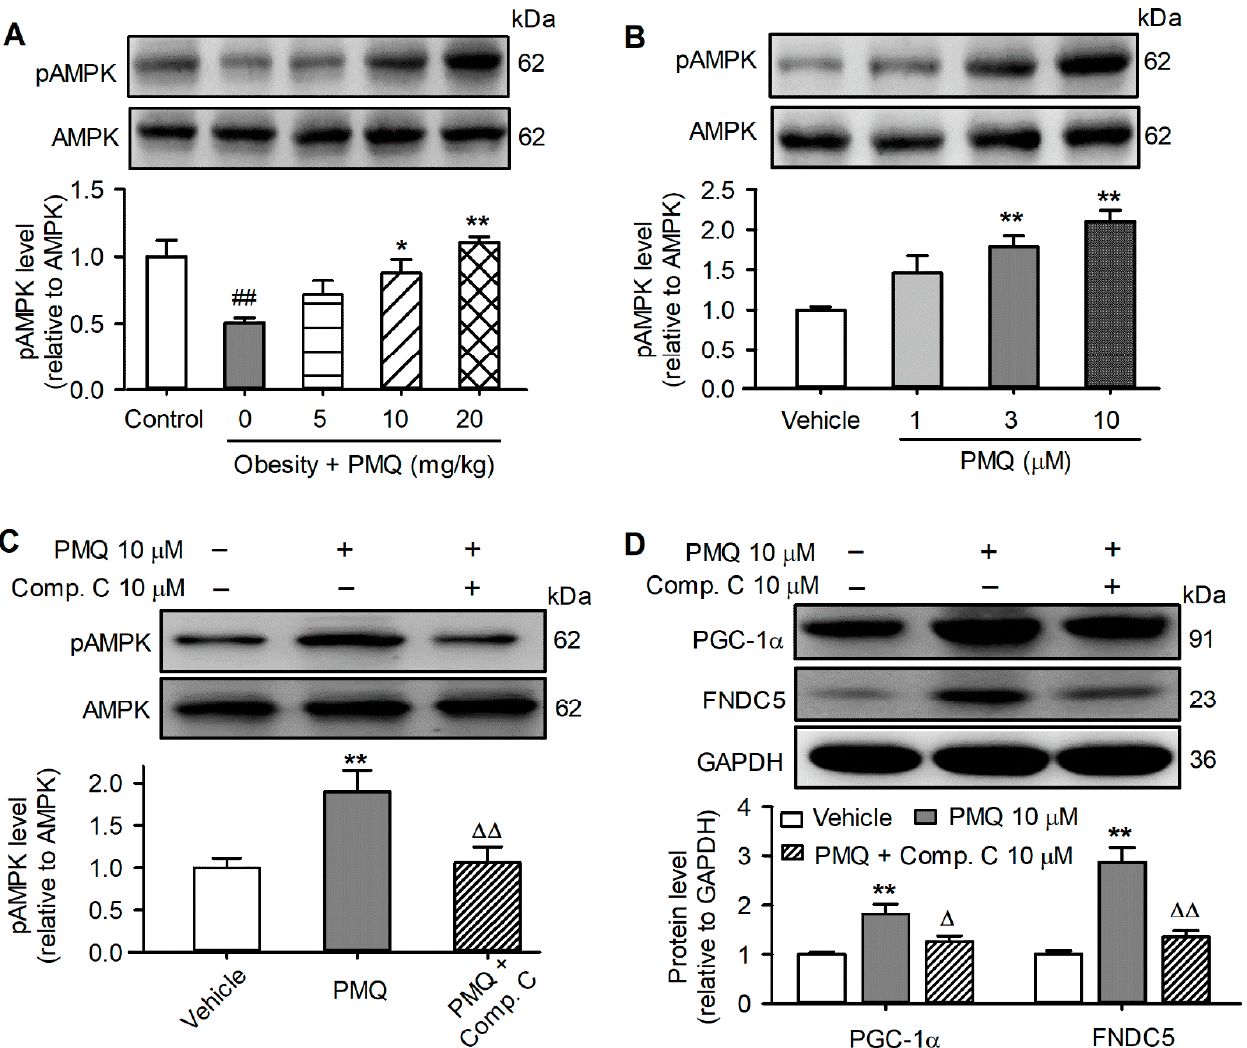
Figure 7. PMQ enhances PGC-1 α and FNDC5 protein expression by activating AMPK. ( A ) Protein levels of pAMPK and AMPK in gastrocnemius muscle of mice. ## p < 0.01 vs control group; * p < 0.05, ** p < 0.01 vs MSG group. ( B ) Protein levels of pAMPK and AMPK in C2C12 myotubes treated with various concentrations of PMQ (1, 3, 10 μ M) or vehicle for 16h. ** p < 0.01 vs vehicle. ( C , D ) Protein levels of pAMPK, AMPK, PGC-1 α , and FNDC5 in C2C12 Myotubes pretreated with or without 10 μ M compound C for 6 h and continuously incubated with PMQ for 16 h. ** p < 0.01 vs vehicle; Δ p < 0.05, ΔΔ p < 0.01 vs. PMQ 10. Data are expressed as means ± SEM, n = 4.